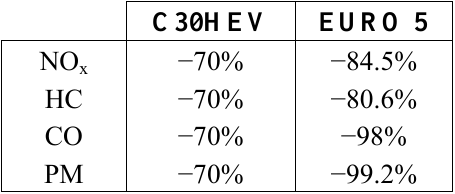
Table 19. Percentage reduction of emissions of the LETHE™ City